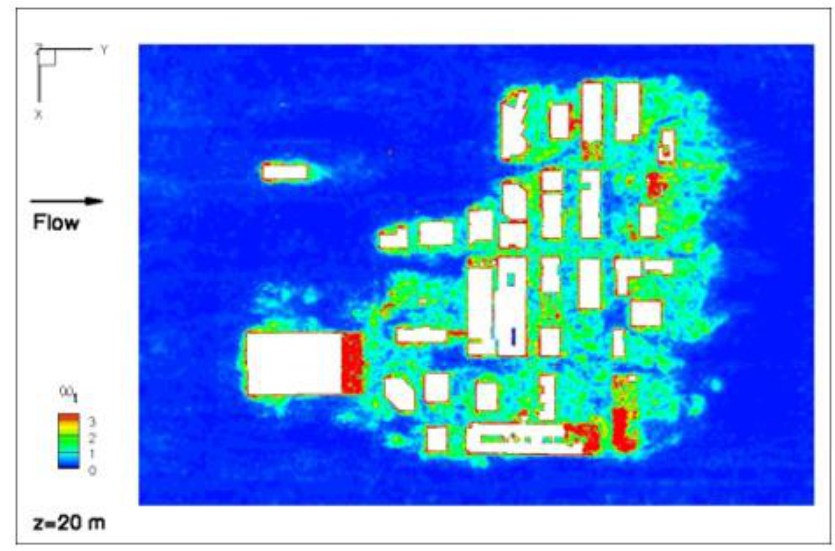
Figure 7. Total vorticity magnitude contours at z = 20 m (see the location of planes in Figure 2).